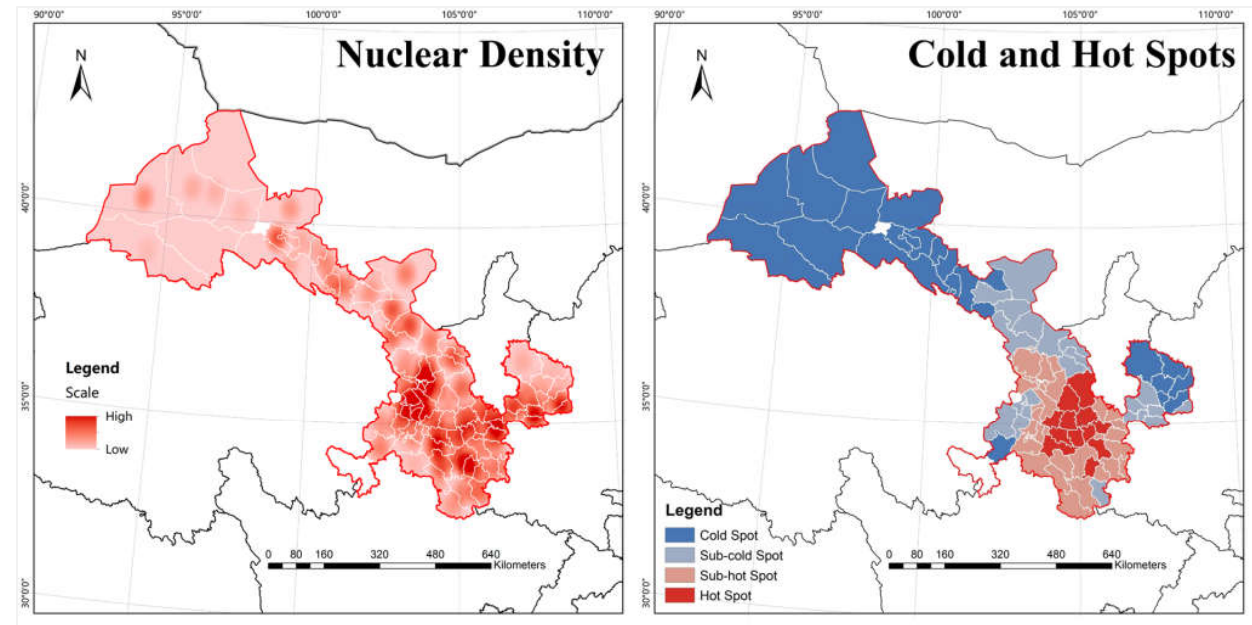
Figure 6. Spatial analysis on economic contribution of real estate in Gansu.